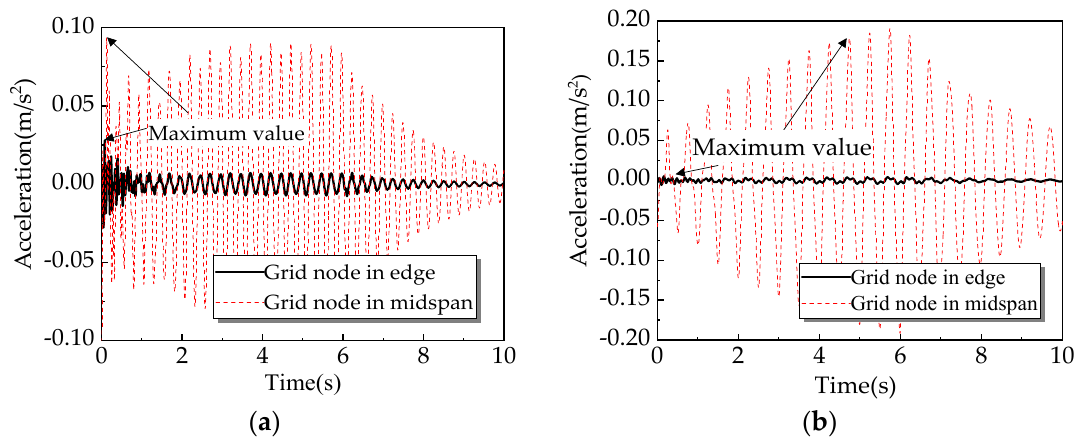
Figure 20. Response time history curves of two human-induced-vibration states: ( a ) resonance; ( b ) nonresonance.